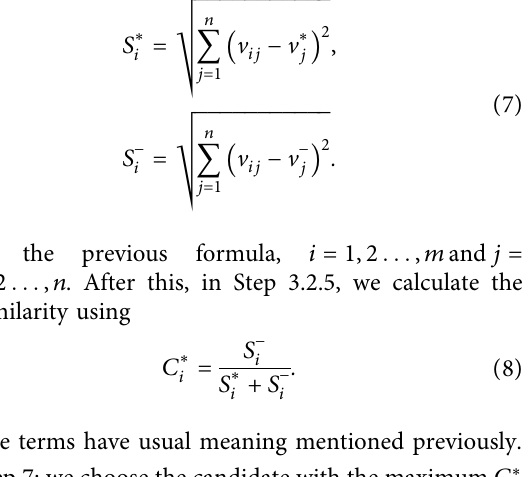
Figure 1: Flowchart of